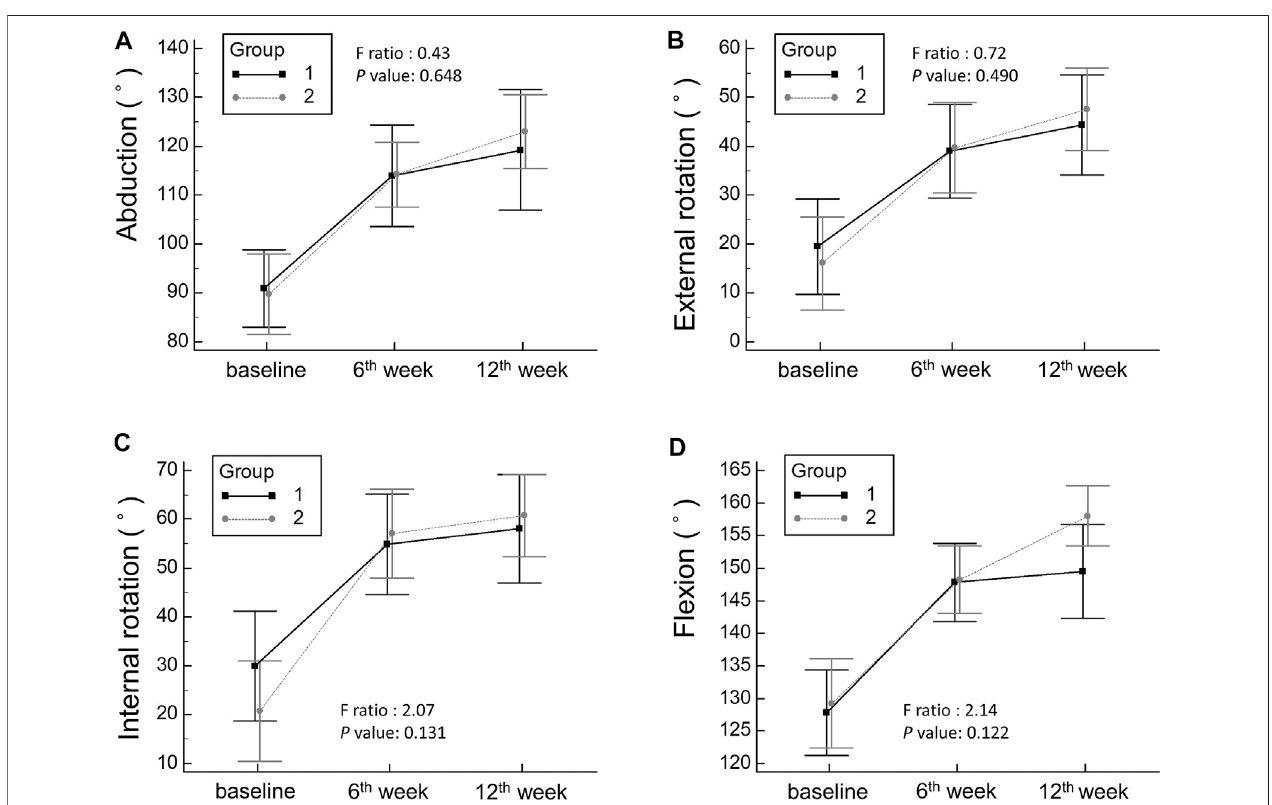
FIGURE 4 | Mean changes and the corresponding 95% con fi dence intervals pertaining to shoulder range of motion in abduction (A) , external rotation (B) , internal rotation (C) , and fl exion (D) . Group 1 indicates hydrodilatation though the posterior glenohumeral recess, whereas Group 2 indicates hydrodilatation through the rotator cuff